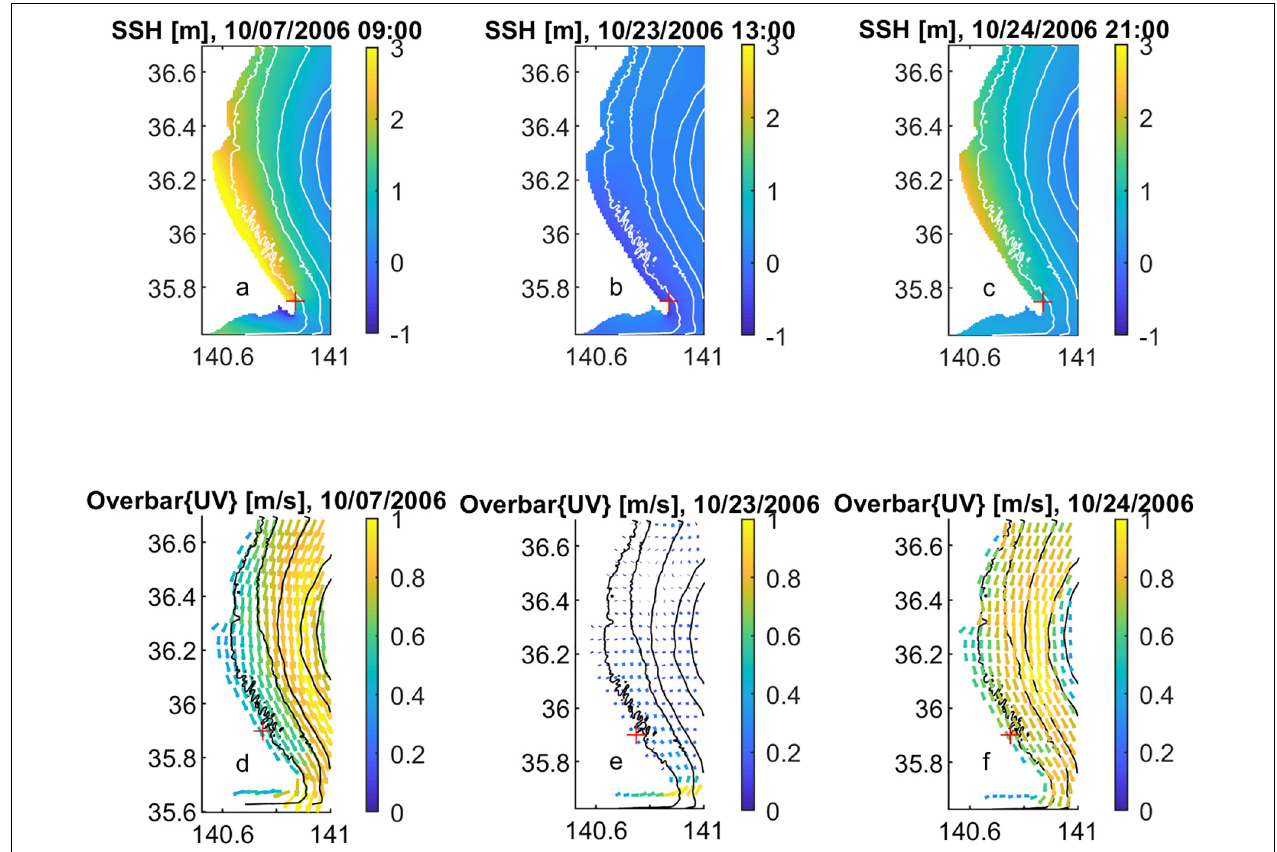
FIGURE 9 | Sea Surface Height (upper) and depth averaged velocity (lower) for October 7 at 9 am (left) , October 23 at 1 pm (middle) and of October 24 at 9 pm (right) . Bathymetry contours represent depths of 25, 50, 100, and 200 m. Red cross indicates the location of the corresponding observed